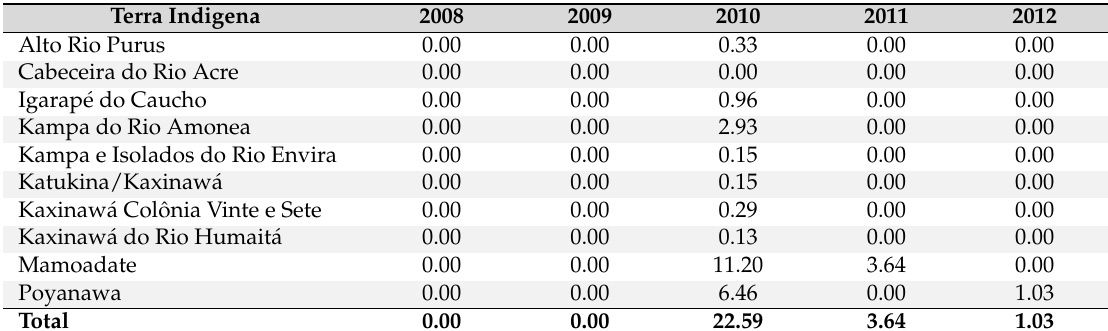
Table A9. Area (km²) of Indigenous land affected by fire through the years analyzed. Terra Indigena Table A9. Area (km 2 ) of Indigenous land affected by fire through the years analyzed.